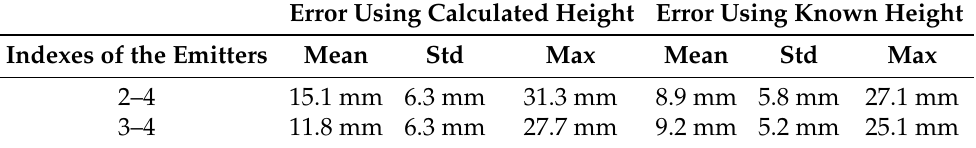
Table 3. Positioning errors using two emitters obtained by formal calibration.